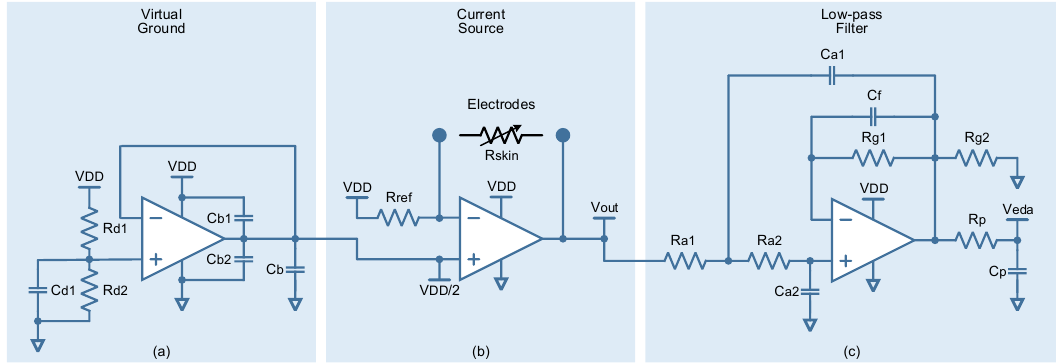
Figure 2. Electrodermal activity sensor building blocks. ( a ) Virtual ground. R d 1 = R d 2 = 100 k Ω , C d 1 = 1 µ F, C b 1 = C b 2 = 100 nF, and C b = 47 µ F; ( b ) Current source. R ref = 825 k Ω ; ( c ) Low-pass